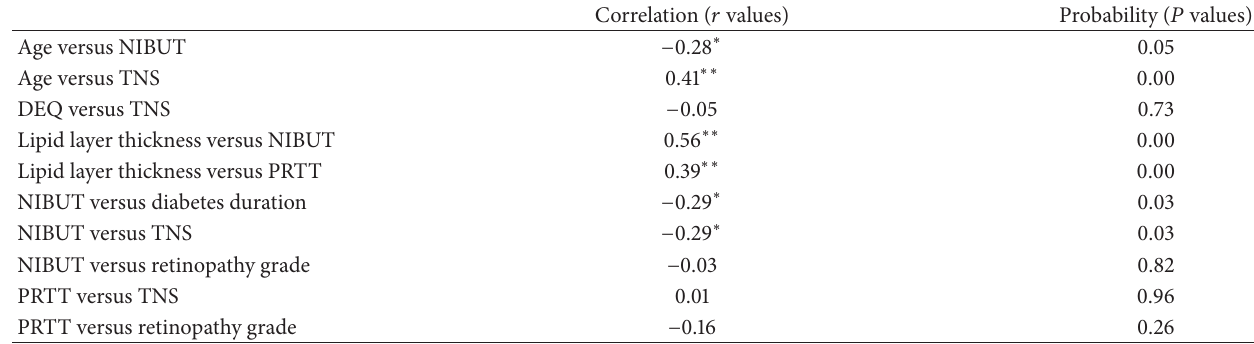
Table 3: Correlation analysis between age, diabetes duration, McMonnies questionnaire scores (DEQ), phenol red thread test (PRTT) (mm), tear film interferometry including lipid layer grade, stability (NIBUT), diabetic retinopathy grading, and total neuropathy score (TNS) in those with DM ( 𝑛 = 53 ).